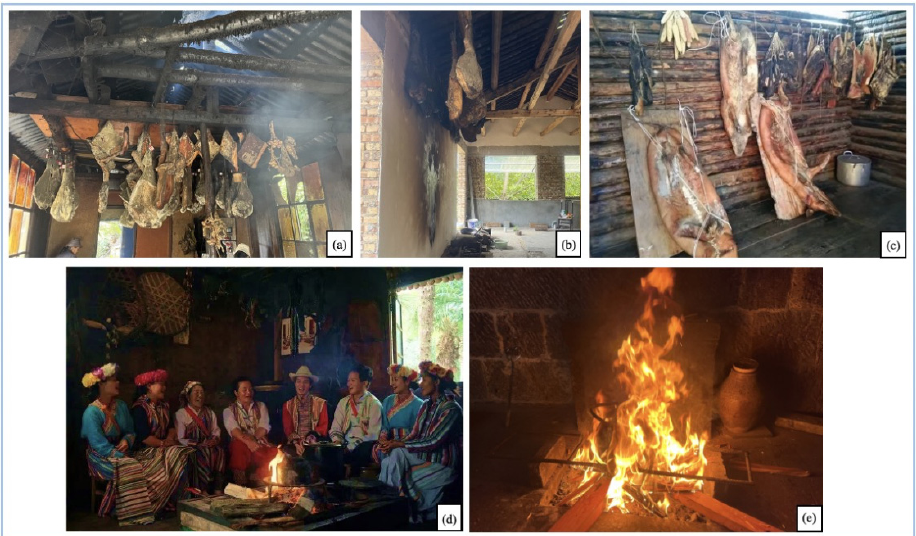
Figure 6. Ham products preserved by different farmers. ( a , b ) The preserved ham hung in the farmer’s house kitchen (also dining room) over the Huo Tang ; ( c ) the fermented Pipa pork stored in a cool, ventilated, and dry place, neat the Huo Tang ; ( d ) the ethnic minority people sitting around the Huo Tang chatting; ( e ) the burning fire Huo Tang . (( a , b,e ) photo by Yanan Chu, August 2022, Photographed in Laowo Village; ( c , d ) photo by Nujiang Lisu Autonomous Prefecture Culture and Tourism Bureau, July 2020, Photographed in Bingzhongluo Village).